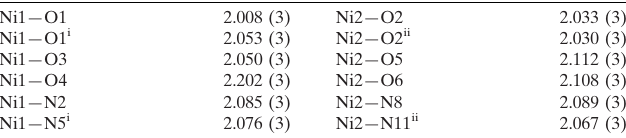
Selected bond lengths (A˚ ).